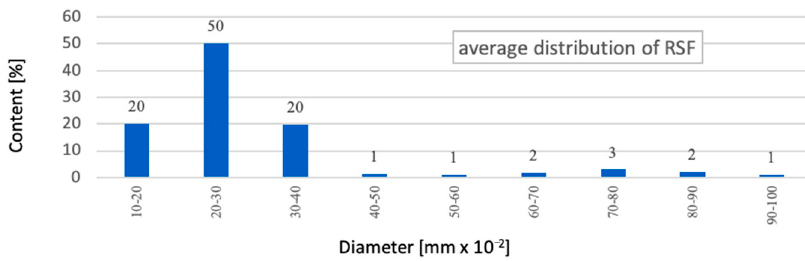
Figure 4. The average percentage of RSF length distribution.